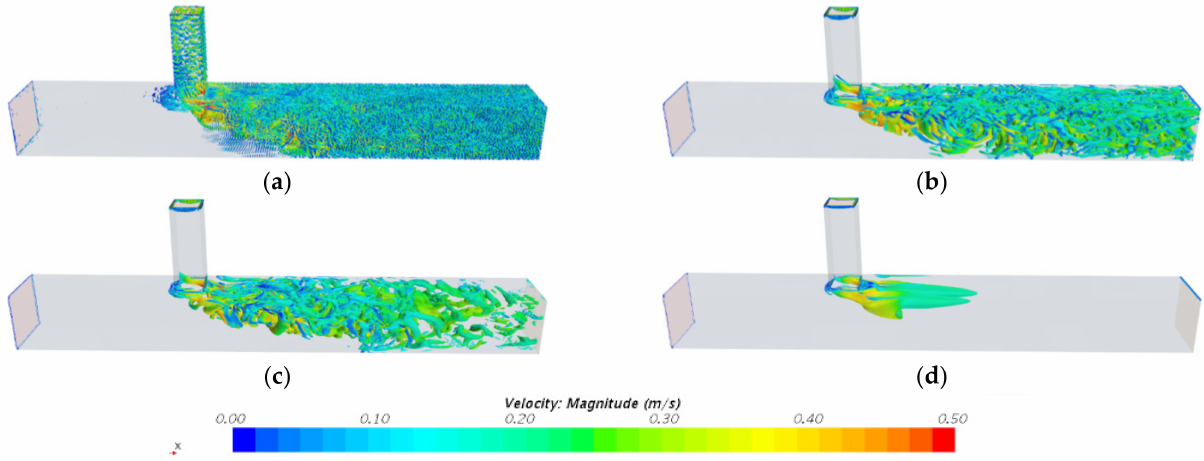
Figure 7. Instantaneous turbulent coherent structures (Q-criterion contours with value of 10) for LES ( a ), STRUCT- ε ( b ), STRUCT-T ( c ) and RKE ( d ) models. The contours are colored by velocity